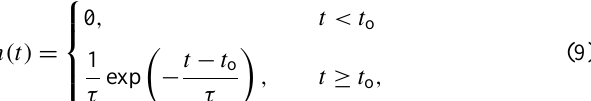
Figure 27. Temperature profiles in the Tulageak Test Well No. 1, Temperature profiles in the Tulageak Test Well No. 1, color-coded by acquisition date (left). Temperature gradients calculated color-coded by acquisition date (left). Temperature gradients calcu- Figure 27. from the 1989, 2003, and 2007 logs are shown in the right panel. lated from the 1989, 2003, and 2007 logs are shown in the right panel.